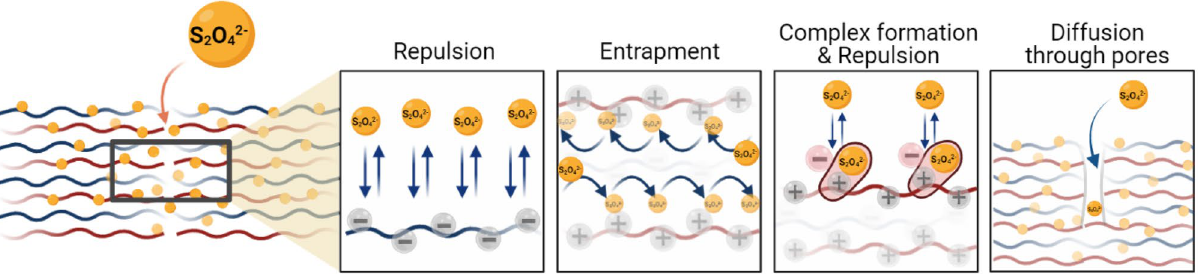
Figure 4. Schematics of the different situations experiencing S 2 O 4–2 when diffusing through a PEM of PAH/